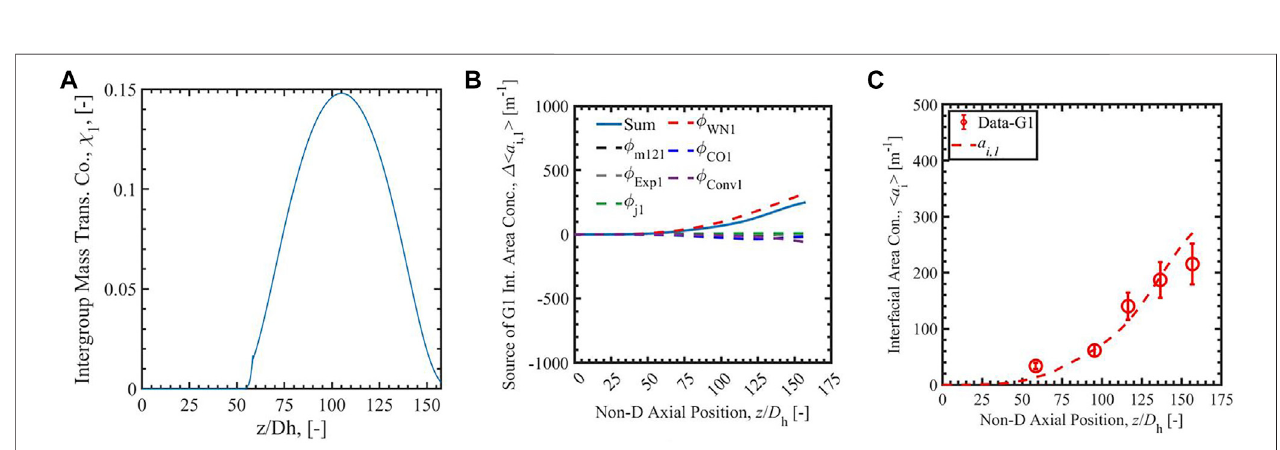
FIGURE 5 | The Run 1 results of group-1 intergroup mass transfer coef fi cient (A) , the source of group-1 interfacial area concentration (B) , and the interfacial area concentration (C) calculated with analytical-RR correlation (Zhu et al., 2020).